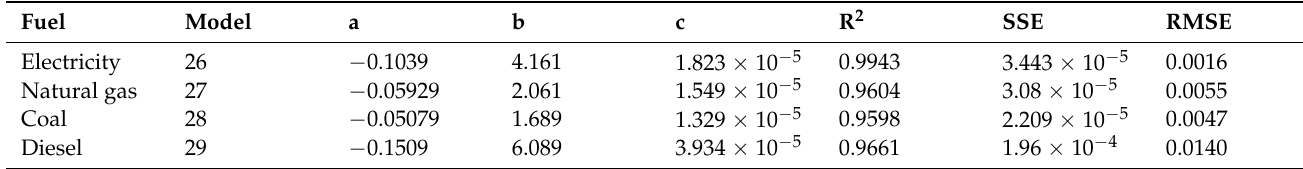
Table 6. Developed model regression